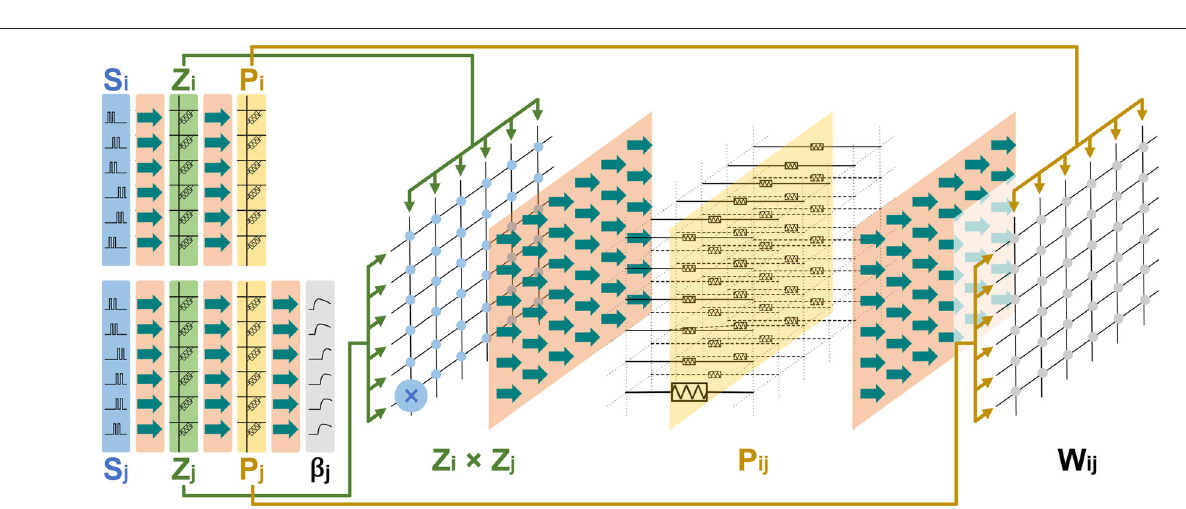
To explore the similarity of the BCPNN traces and the memristor non-linearity, the curve of the BCPNN trace